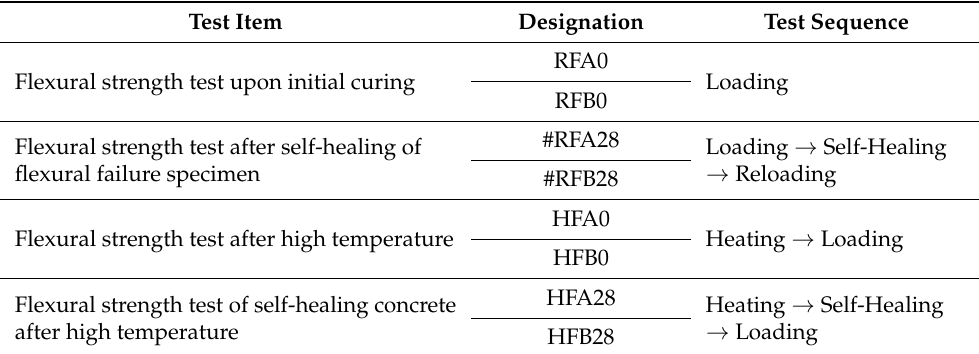
Table 4. Flexural test items and test